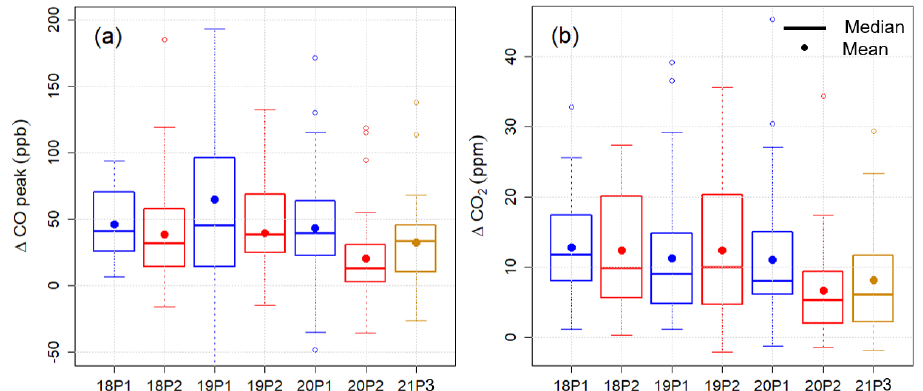
Figure 7. Box and whisker plot of ( a ) calculated ∆ CO peak in Section 2.4 on weekdays and ( b ) daily ∆ CO 2 from 12:00 to 16:00 local time on weekdays for the seven periods examined. The description of the box and whisker plots is the same as for Figure